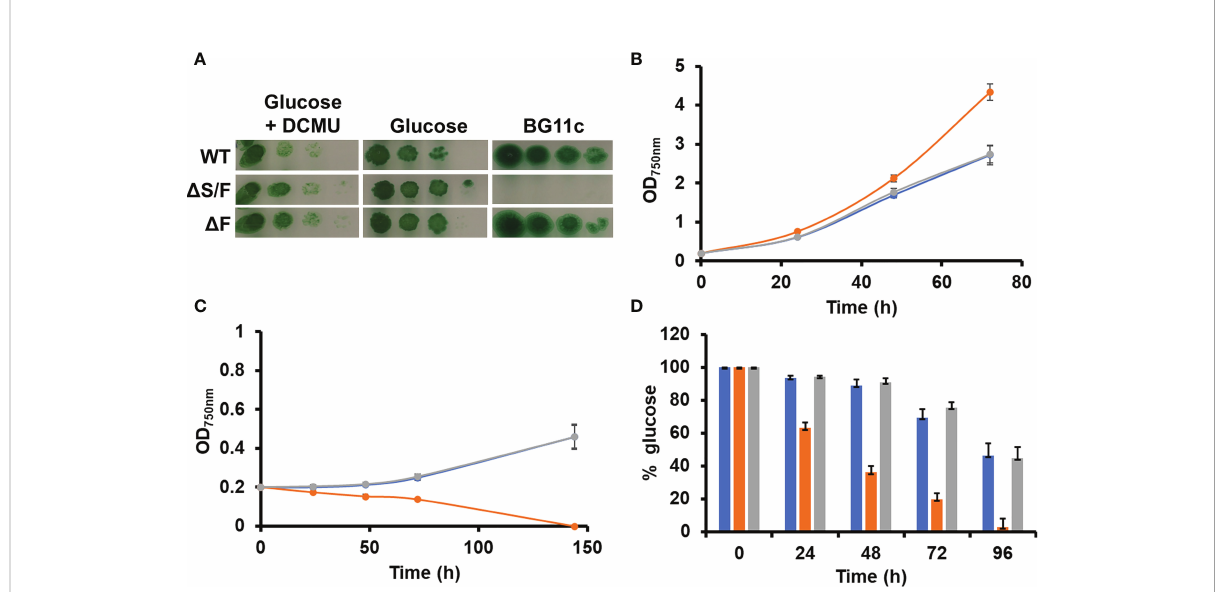
FIGURE 1 Growth of WT, D S/F, and D F strains in different trophic regimes. (A) Growth of WT, D S/F, and D F in different trophic regimes in solid media. Tenfold serial dilutions of a suspension of 1 µg of chlorophyll ml − 1 cells grown in BG11C supplemented with glucose were spotted onto plates of BG11C supplemented with 10 mM glucose and 20 µM DCMU, BG11C supplemented with 10 mM glucose, or BG11C. Plates were incubated at 5 µmol photon m − 2 s − 1 and photographed after 10 days of growth. (B) Photomixotrophic growth of WT, D S/F, and D F in liquid media. WT ( ○ ), D S/F ( ○ ), and D F ( ○ ) were grown in BG11C + 10 mM glucose in low light until the exponential phase. Cells were washed twice in BG11C and inoculated in BG11C supplemented with 10 mM glucose at OD 750nm 0.2 under the same conditions. Growth was monitored by measuring OD 750nm . Data represented are the mean and standard error of three to four (depending on the time point) biological independent cultures. (C) Photoautotrophic growth of WT, D S/F, and D F in liquid media. WT ( ○ ), D S/F ( ○ ), and D F ( ○ ) were grown in BG11C in low light until the exponential phase. Cells were washed twice in BG11C and inoculated in BG11C OD 0.2 under the same conditions. Growth was monitored by measuring OD 750nm . Data represented are the mean and standard error of three to four (depending on the time point) biological independent cultures. (D) Glucose consumption in WT, D S/F, and D F. WT ( ○ ), D S/F ( ○ ), and D F ( ○ ) were grown in BG11C + 10 mM glucose in low light until the exponential phase. Cells were washed twice in BG11C and inoculated in BG11C supplemented with 10 mM glucose. Glucose present in the media was determined as described, and the % of the total glucose present is represented. Data are the mean ± SE of at least three biologically independent